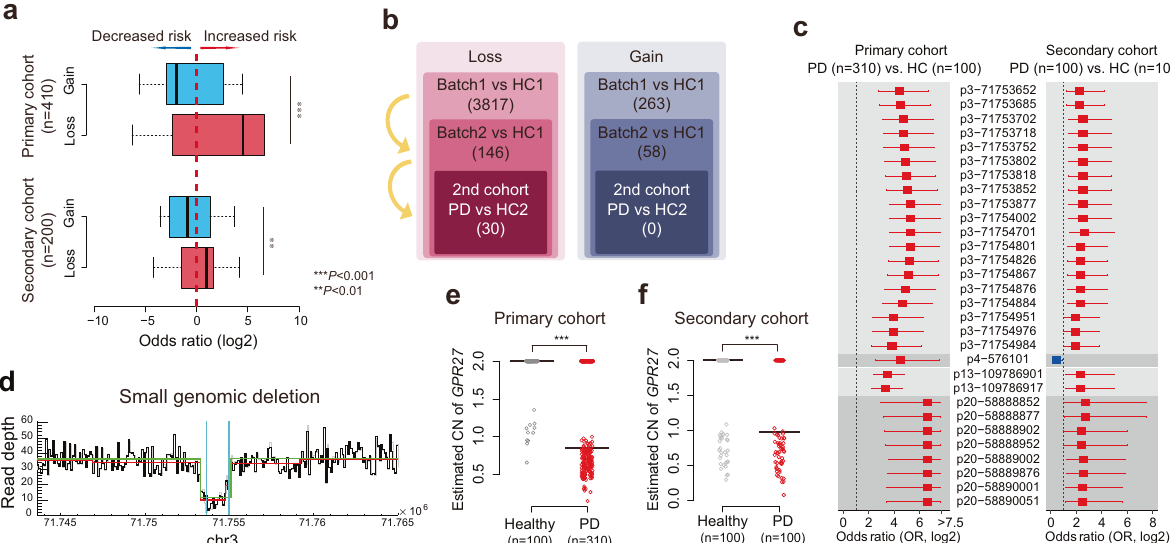
Fig. 4 CNV and risk of PD. a Odds ratios of the signi fi cantly different CNVs according to CN loss or CN gain in the primary and secondary cohorts (Wilcoxon-rank sum test). b Selection of signi fi cant CN variations associated with the risk of PD using multiple cohorts. c Odds ratio of 30 signi fi cant PD risk-associated SGDs in the primary and secondary cohorts. d Representative image of SGDs at chromosome 3. e , f CNVnator- estimated CN of SGDs in GPR27 of PD and healthy individuals in the primary and secondary cohorts (Wilcoxon-rank sum test). CN copy number; CNV, copy number variation; PD Parkinson ’ s disease; SGD small genomic factor Tcf7l2 is upregulated in Thy-aSyn mice and is signi fi cantly deregulated in PD models using neuroepithelioma cells chroni- cally exposed to rotenone 43 . We analyzed TCF7L2 ChIP-seq data for several cell lines from the ENCODE database (https://www.encodeproject.org). One of the best matched motifs was in TCF7L2 (Fig. 3c), which suggests the high quality of the TCF7L2 ChIP-seq data. The predicted target genes for the TCF7L2 binding site are signi fi cantly enriched in the Wnt signaling pathways (Fig. 3d). In addition, we used DepMap data to identify CTNNB1 as the top codependent gene of TCF7L2 (Fig. 3e), and the beta-catenin pathway was found to be signi fi cantly associated with TCF7L2 activity (Fig. 3f – g). The Wnt / beta-catenin pathway is involved in dopaminergic neuron survival and PD pathogenesis 44 . Therefore, changes in the beta-catenin pathway owing to the regulatory effect of TCF7L2 may contribute to the development of PD. Small genomic deletions and increased risk of PD Germline copy number (CN) gains and losses across the whole algorithms (Supplementary Fig. 10). In the primary cohort, signi fi cantly different (Fisher ’ s exact test P < 1.0 × 10 -5 ) global